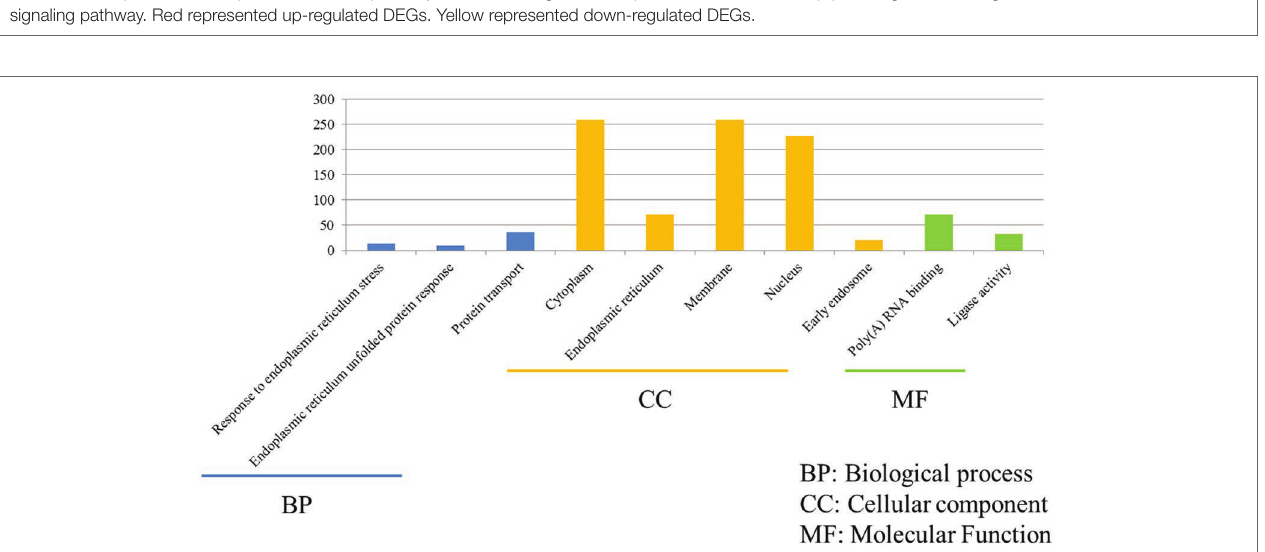
FIGURE 5 | Functional annotations and bioinformatic characterization of unique DEGs in P815 cells infected with H5N1 virus compared with H7N2 virus. The GO biological process terms, GO cellular component terms and GO molecular function terms of unique DEGs in P815 cells infected with H7N2 virus were analyzed compared with H5N1 virus. Blue bar chart represented biological classification of the IAV-regulated unique DEGs in P815 cells. Orange bar chart represented cellular classification of the IAV-regulated unique DEGs in P815 cells. Green bar chart represented molecular classification of the IAV-regulated unique DEGs in P815 cells.